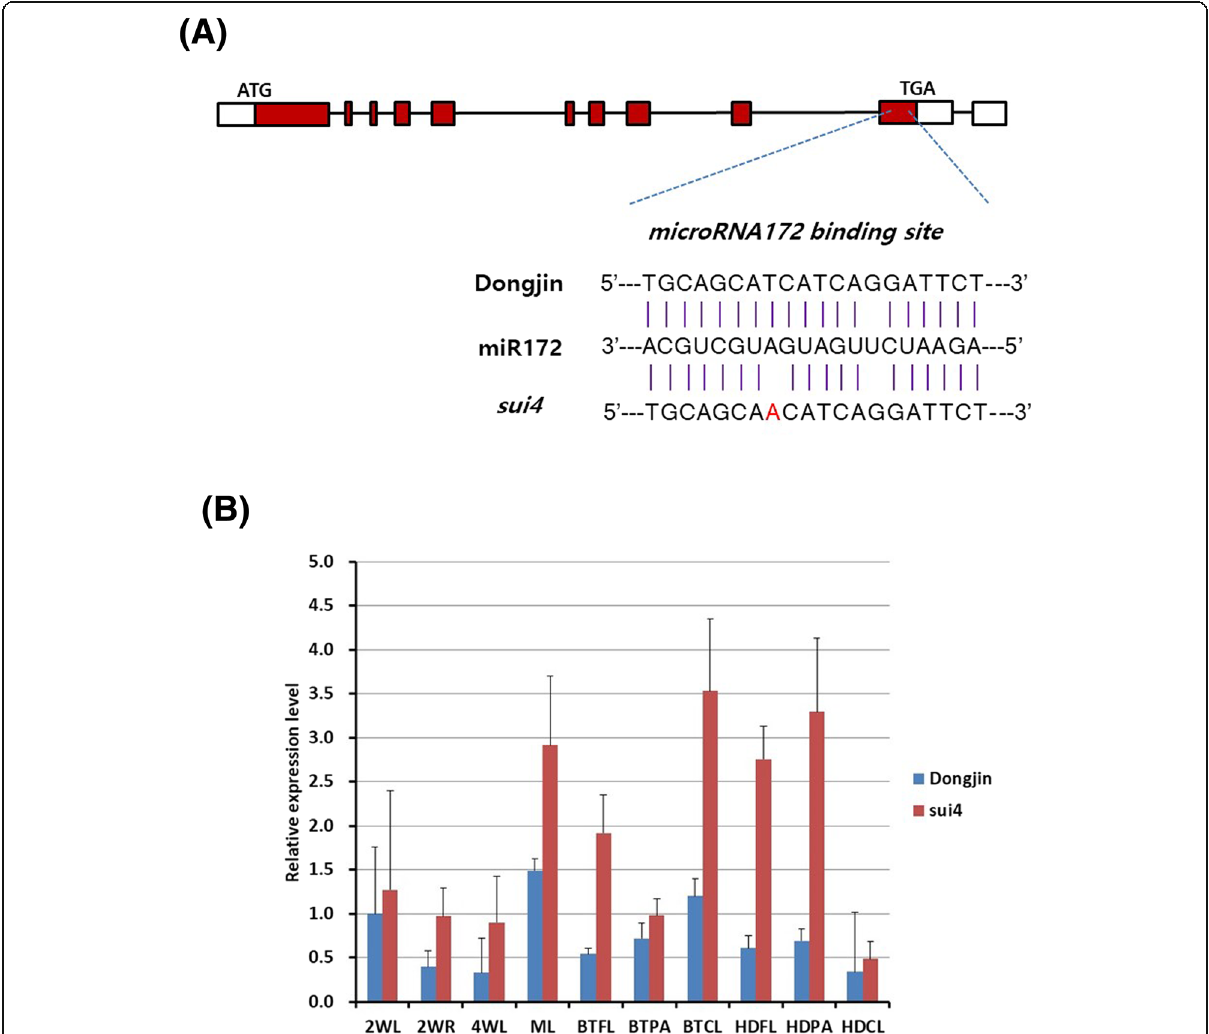
Fig. 3 Os07g0235800 gene mutation and expression pattern. ( a ) Structure of the Os07g0235800 gene and location of mutation. Empty boxes indicate 5 ′ and 3 ′ UTRs, filled boxes indicate CDS, and lines indicate introns. ( b ) Expression pattern of Os07g0235800 at different developmental stages and organs in Dongjin plants and sui4 mutants. Relative fold expression difference is based on the expression level detected in two-week- old leaves as a baseline. Error bars represent standard deviation of the expression ratio. 2WL: two-week-old seedling leaf. 2WR: two-week-old seedling root. 4WL: four-week-old seedling leaf. ML: middle stage (70-day-old plant) leaf, BTFL: flag leaf of booting stage plant, BTPA: panicle